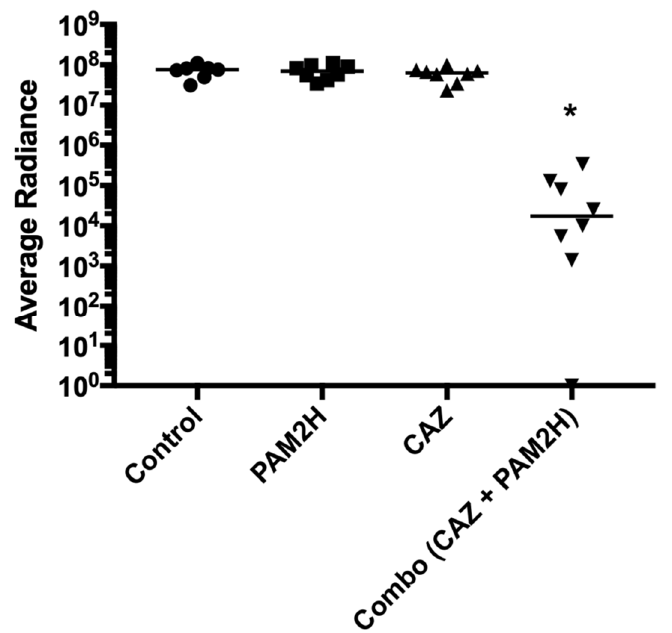
Figure 2. Quantification of the bacterial luminescence for mice from each treatment group as determined by IVIS on day 4 at the completion of treatment. * p < 0.05.